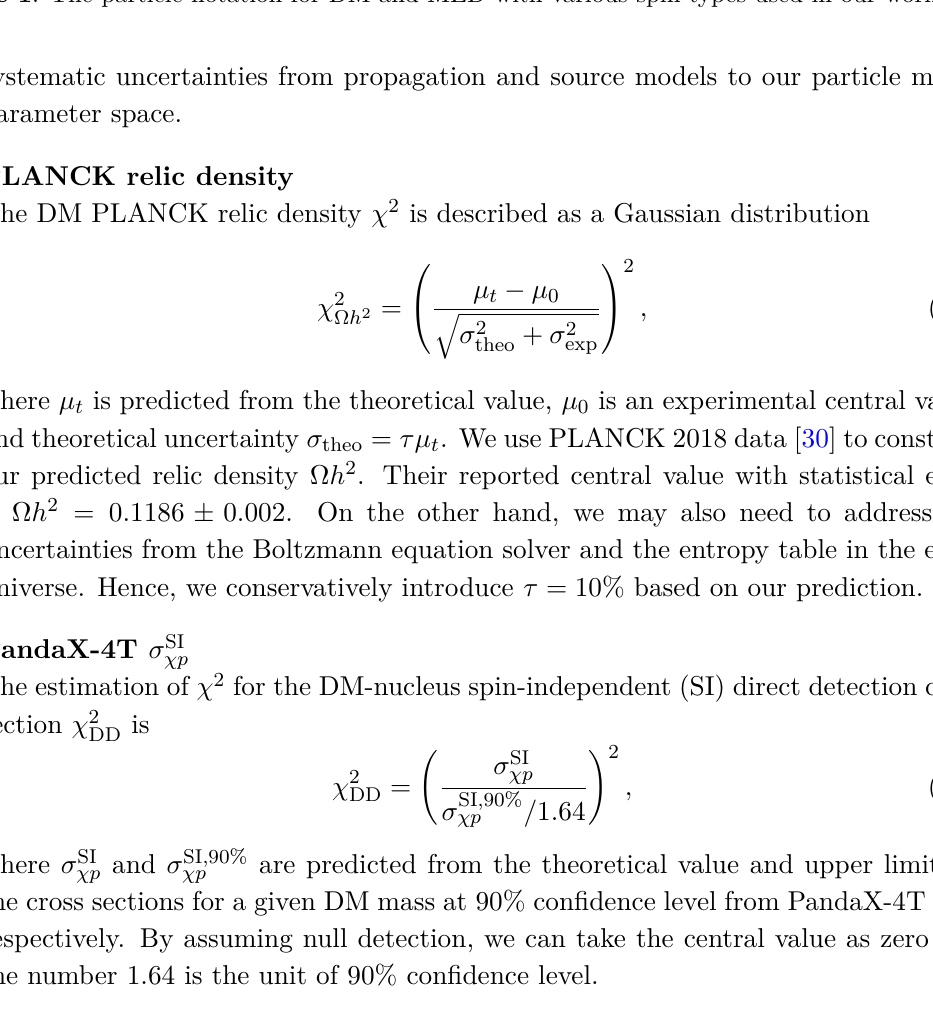
Table 1 . The particle notation for DM and MED with various spin types used in our work.